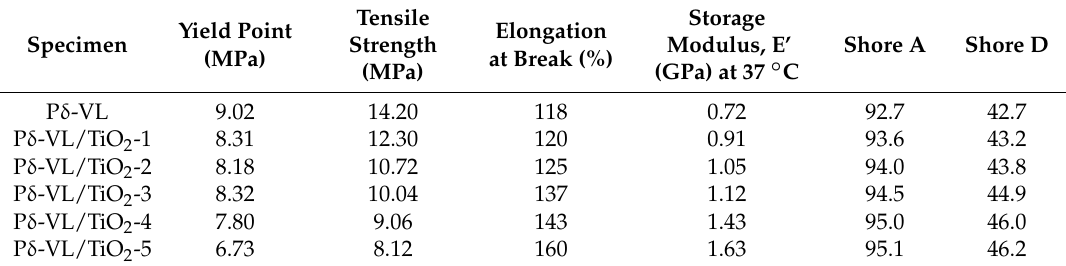
Figure 5. Typical stress–strain curve for pure P δ -VL and P δ -VL/TiO 2 films, prepared by the SC method, undergoing tensile strain testing. Table 2. Mechanical properties of neat P δ -VL and P δ -VL/TiO 2 systems.